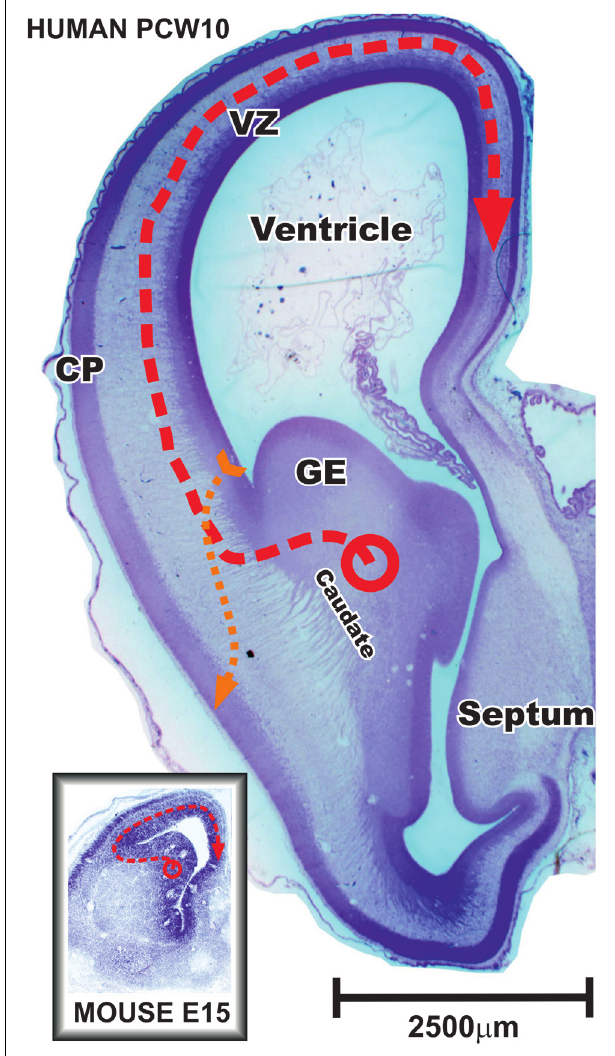
FIGURE 3 | Frontal section through the anterior part of the fetal human and mouse brain during early stages of cortical neurogenesis. In primates during the early fetal period and in rodents during whole neurogenesis vast majority of cortical plate (CP) GABAergic neurons are produced in the ganglionic eminence (GE) and migrate tangentially into the cerebral cortex (red dashed line). Note that neurons tangentially migrating to the most distant positions in the mouse brain might pass the same distance as certain radially migrating glutamatergic principal cells in human brain (yellow dashed line) that originate in the pallial ventricular and subventricular zone (VZ). During middle trimester of gestation, when majority of cortical neurons are born, discrepancy in scaling between human and mouse is much more pronounced. Modified from Petanjek etal.